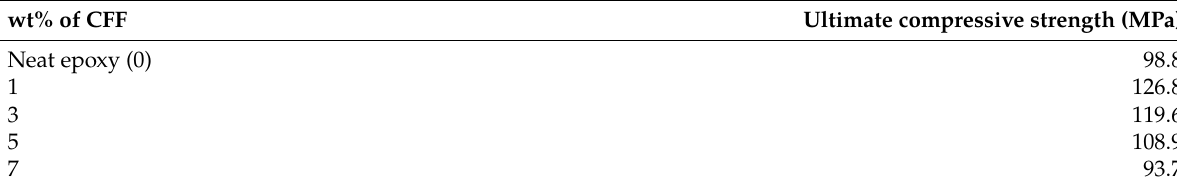
Table 6: Ultimate compressive strength for different compositions of CFF composite.